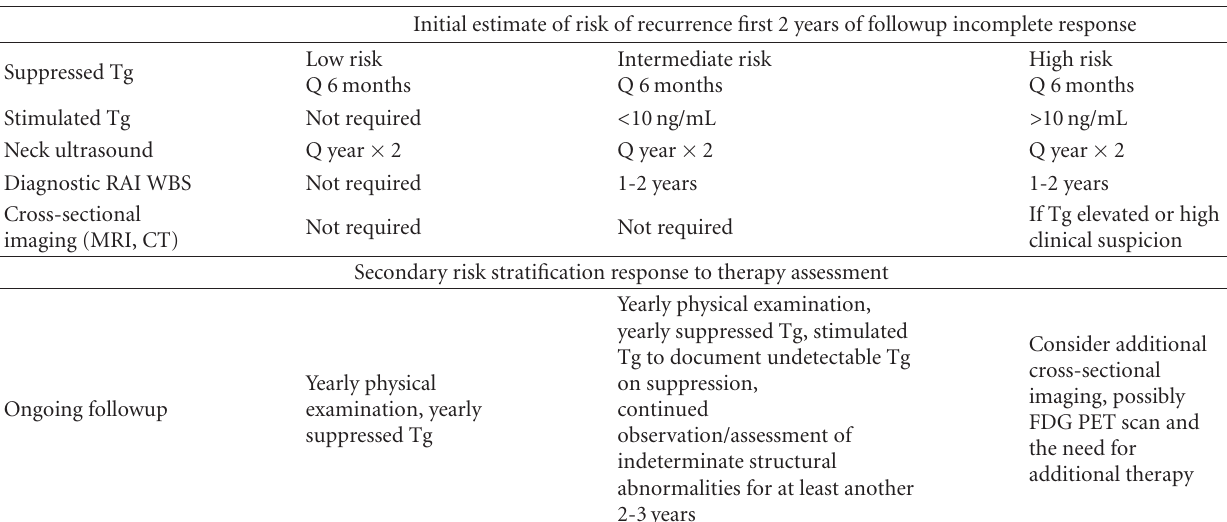
Table 2: Follow-up strategy based on risk groups (adapted from